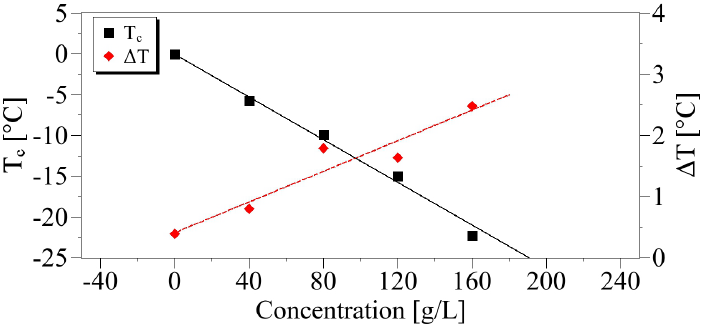
Figure 8. Linear relationship between the parameter A